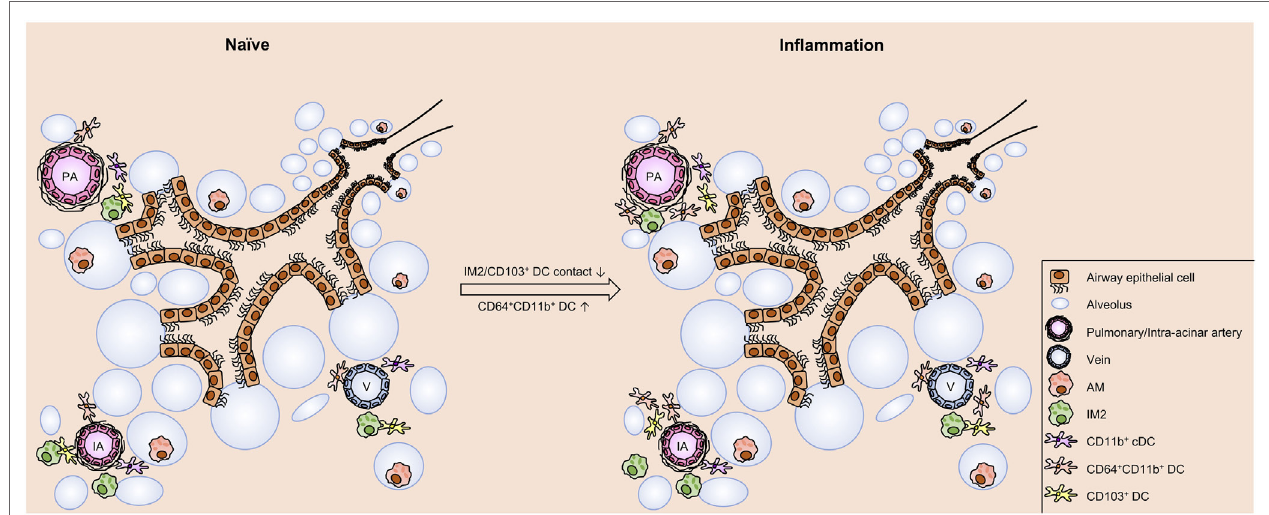
FigUre 9 | Schematic view on cell distribution and interaction in naive mice and upon allergic sensitization. In the naive lung of C57BL/6 mice clusters of phagocytes are found around IAs, pulmonary arteries, and Vs. These clusters comprise dendritic cells (DCs) (CD103 + DCs, CD11b + DCs, and CD64 + CD11b + DCs) and interstitial macrophages 2 (IM2). Within the clusters contacts between CD103 + , DCs and IM2 were observed. Allergic sensitization induces an increase in CD64 + CD11b + DCs without changing the distribution pattern of the investigated cell types. However, allergic immunization reduces the frequency of interactions between CD103 + DCs and IM2. In contrast to the aforementioned cells, alveolar macrophages (AMs) are localized both under naive and asthmatic conditions in the alveolar lumen without any close contact to other phagocytes. Abbreviations: AW, airway; IA, intra-acinar artery; V,